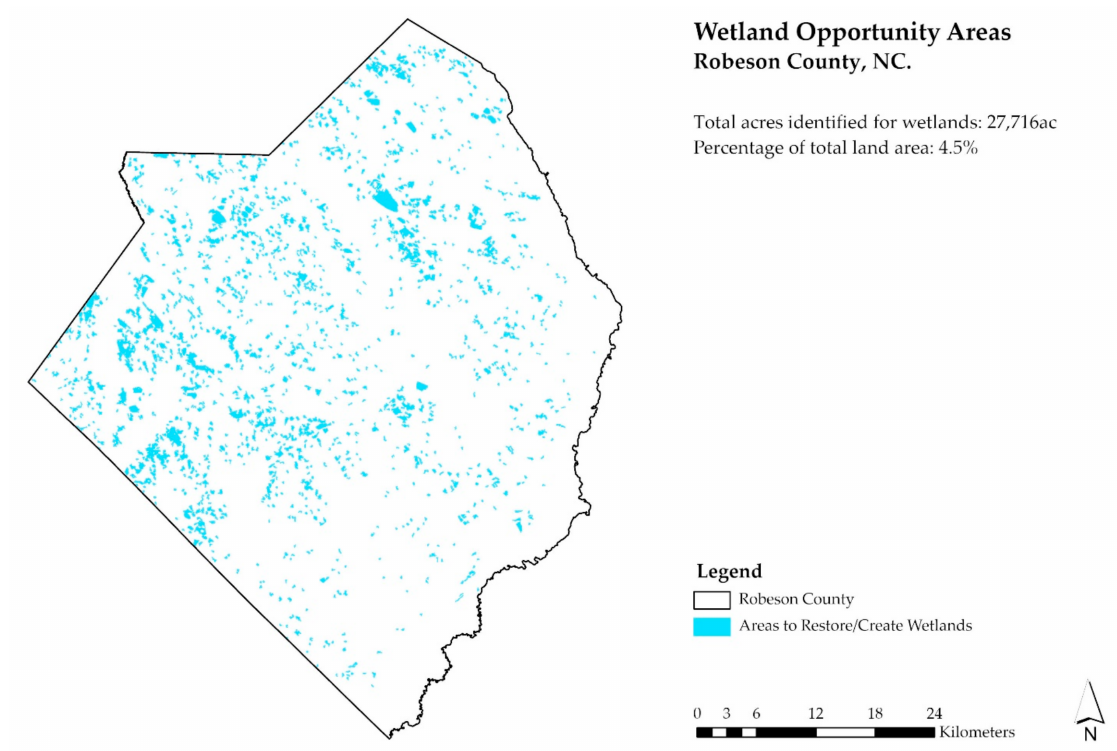
Figure 13. Wetland restoration or creation opportunity areas in Robeson